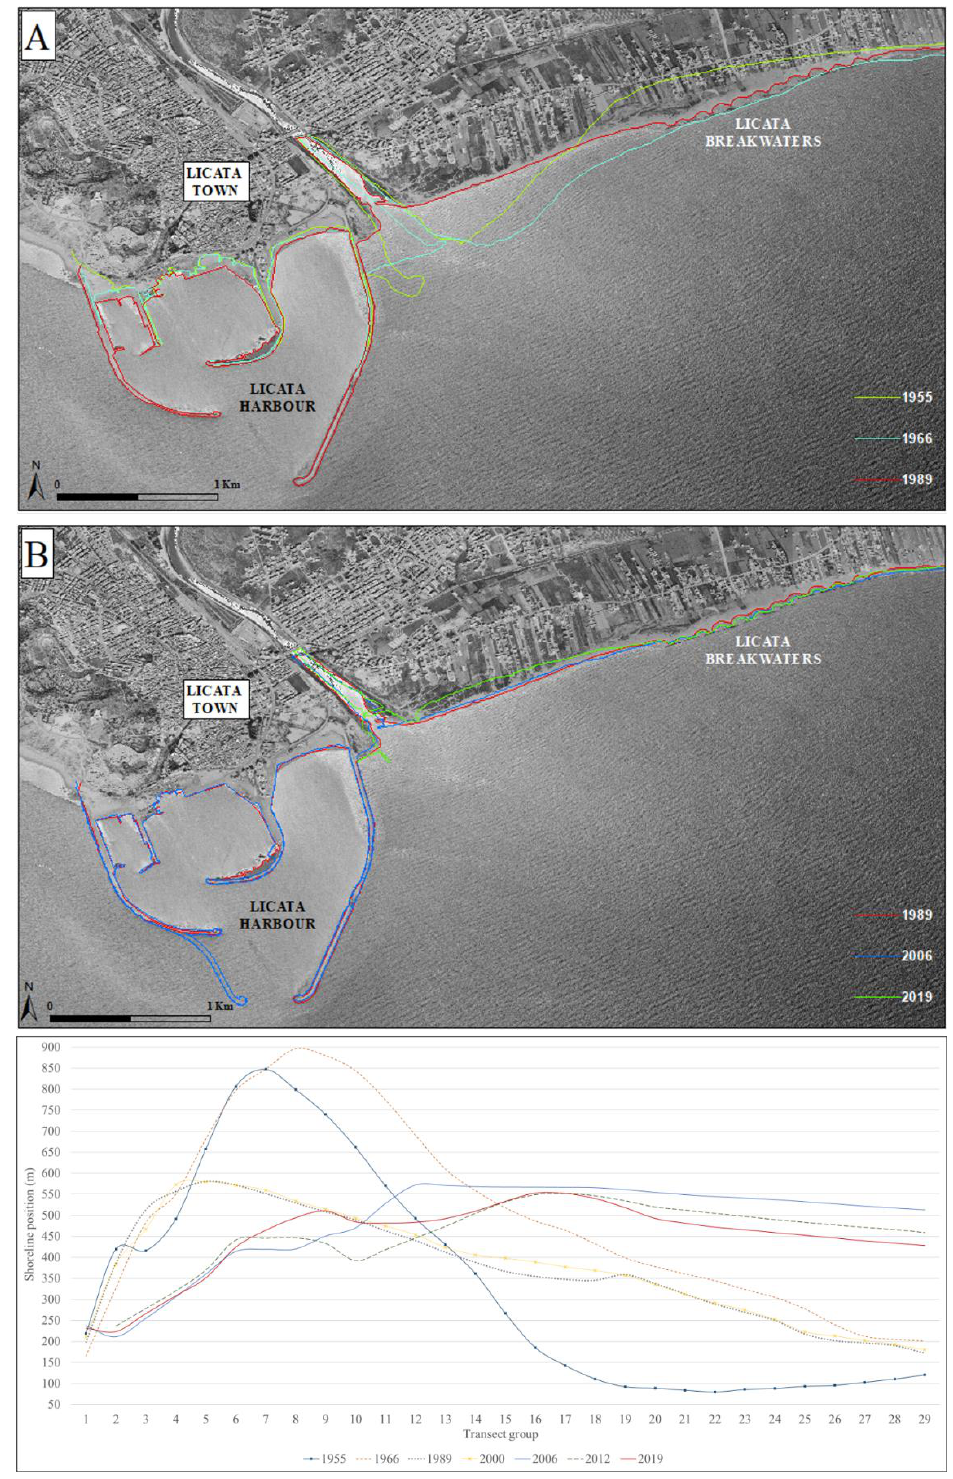
Figure 10. The shoreline evolution of the Southern Imera River mouth and the area east of the mouth. The trend seemed to be negative between 1955 and 2016, but the Shoreline Change Envelope revealed that ( A ) significant accretion has been recorded between 1955 and 1966, and very high erosion has been registered between 1966 and 1989, as shown by the interpolated plot of the shoreline changes (1 transect group = 100 m), but ( B ) shoreline moved seaward between 1989 and 2016 where a set of eleven breakwaters was emplaced.